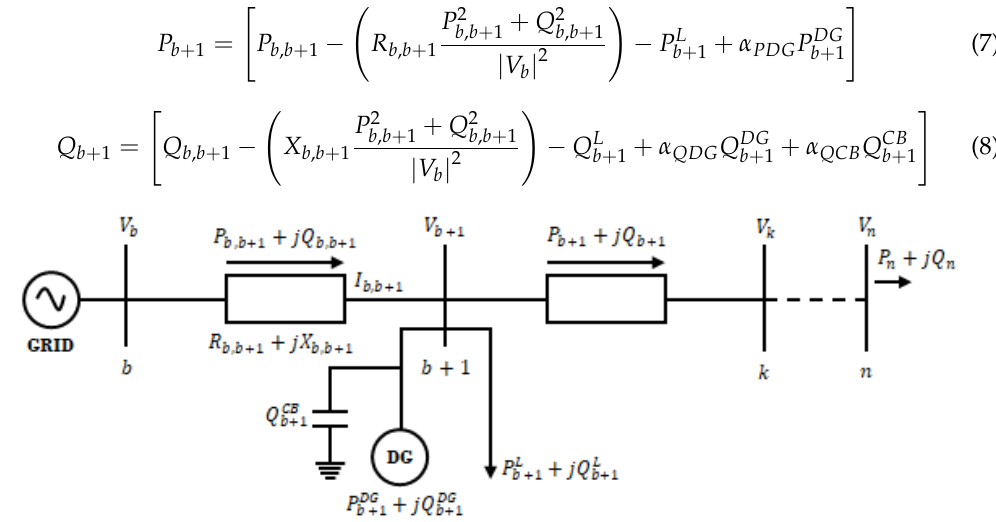
Figure 3. Radial distribution system with DG and capacitor banks equipped on a